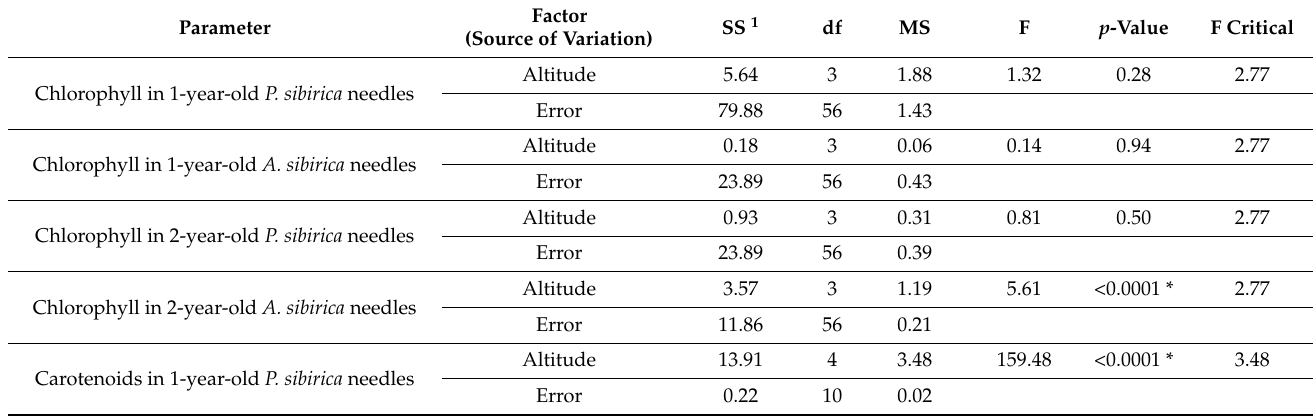
Table A2. One-way ANOVA results on the influence of needle age and altitude a.s.l. on pigment content.